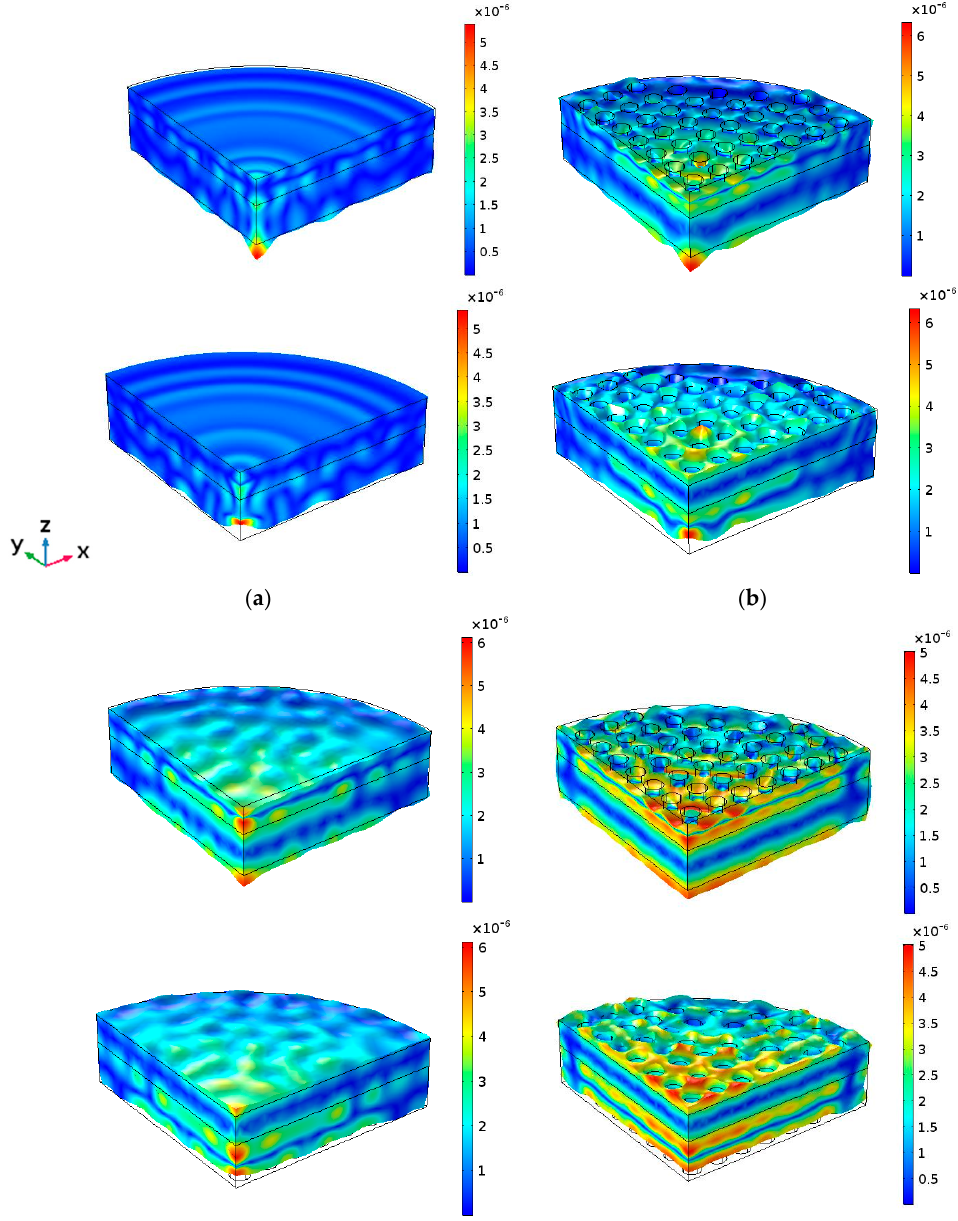
Figure 3. Z direction vibration amplitude calculated results for the four models at their respective main thickness resonance (one wavelength resonance). ( a ) Maximum elongation time position of the aluminum face ( up ) and minimum elongation time position ( bottom ) of Model 1. The same for Model 2 ( b ), Model 3 ( c ) and Model 4 ( d ). The excitation voltage of the piezoceramic disc in all the models was 1V. The bar scale is in mm. The frequency for each model was 997 kHz, 951 kHz, 988 kHz and 894 kHz, respectively.